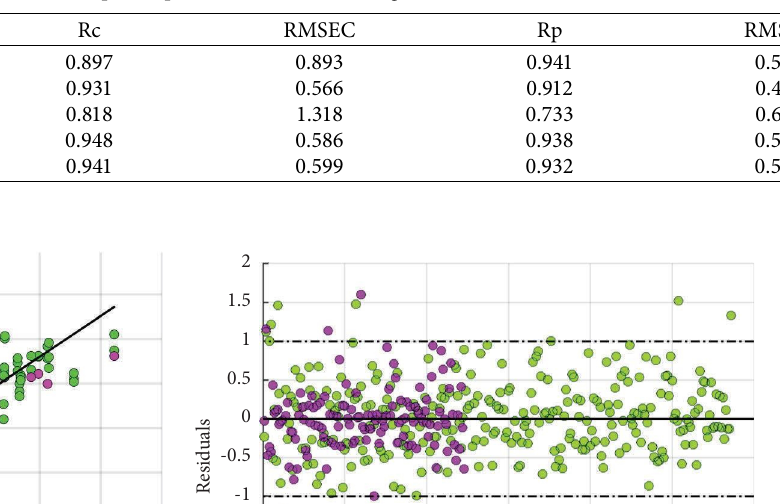
Table 2: Efect of spectra pre-treatment on PLS regression.